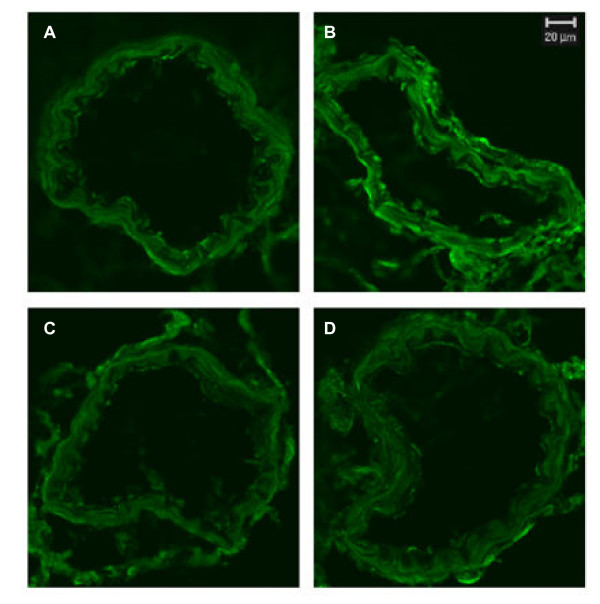
ETB receptor protein in (A) Ro-32-0432 RMCA, (B) control RMCA, (C) Ro-32-0432 LMCA and (D) control LMCA. There was an enhanced expression of ETB receptor protein in the smooth muscle cells in the ischemic RMCA (B). Treatment with Ro-32-0432 abolished this (A). Pictures were taken at 40× magnification.